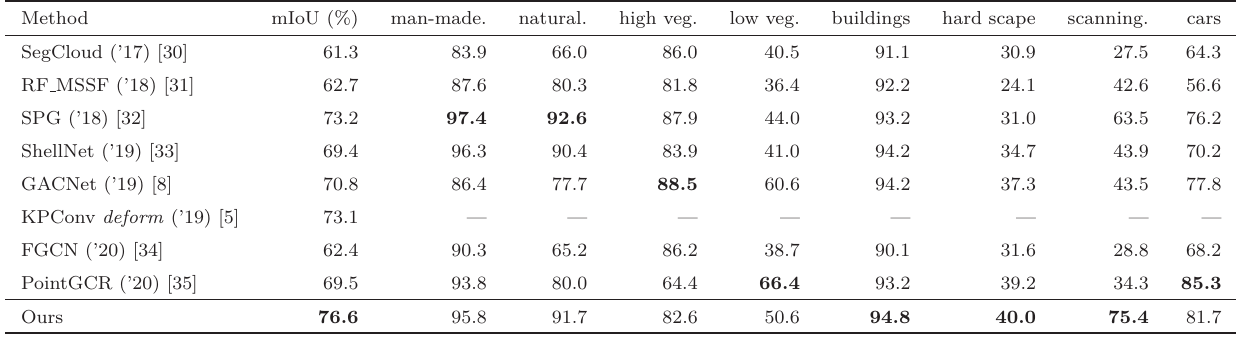
Table 1 Results of outdoor space semantic segmentation on Semantic3D (reduced-8) Method mIoU (%)